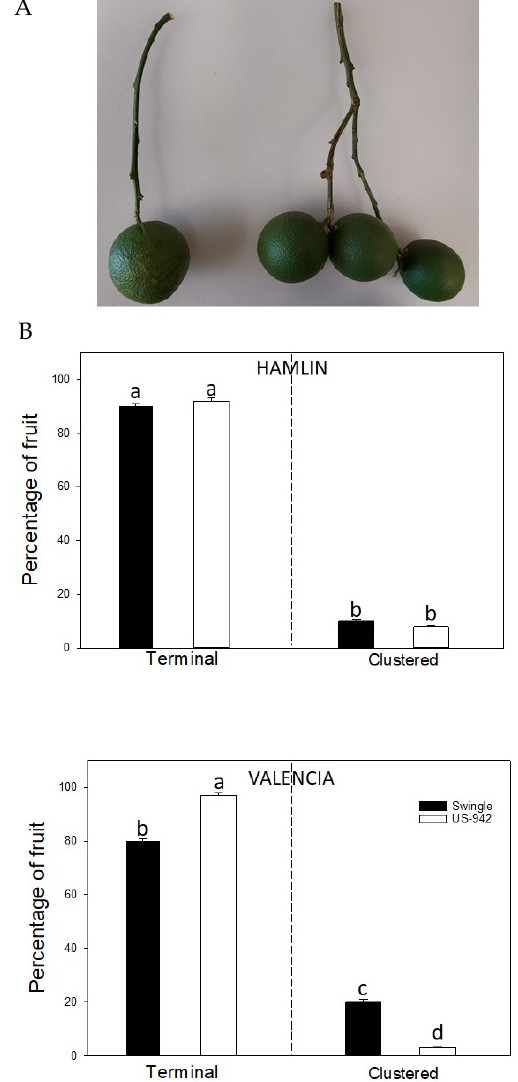
Figure 1. Fruiting characteristics of Valencia and Hamlin scions grafted on Swingle and US-942 rootstocks. ( A ), terminal vs clustered fruit comparison; ( B ), Percentage of fruit from each category in Hamlin And Valencia grafted in both rootstocks. Error bars represent standard errors. Data are means of four biological replicates. Bars with the same letters are not significantly different at p - value significant at 5% according to Tukey-Kramer.